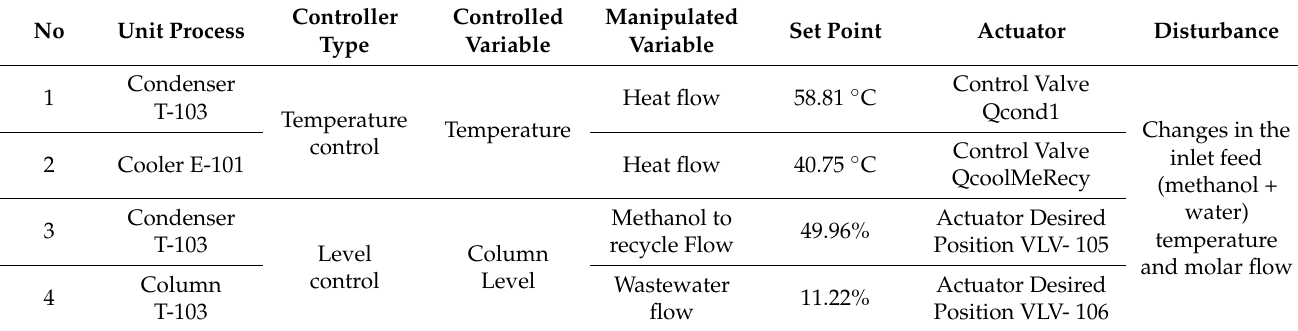
Table 3. CV and MV of the methanol purification process.